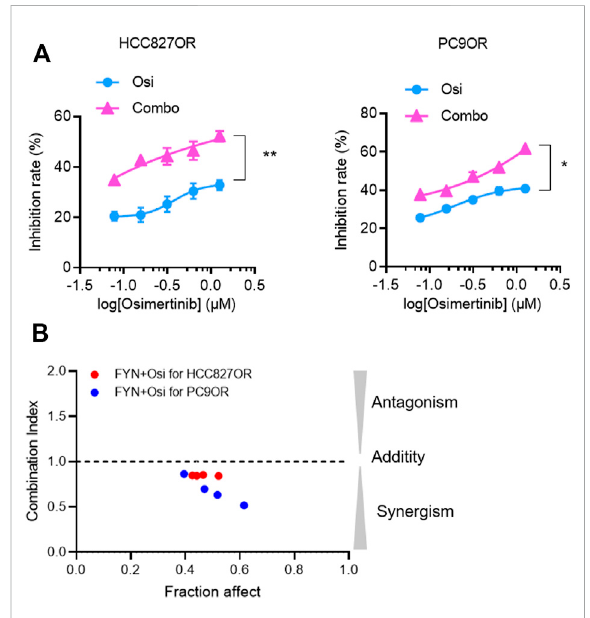
FIGURE 2 Synergistic effects of FYN with osimertinib on osimertinib- resistant NSCLC cells lines. (A) HCC827OR cells were treated for 48 h with 4 μ M osimertinib alone, or in combination with 250 μ g/ ml FYN. PC9OR cells were treated for 48 h with 6 μ M osimertinib alone, or in combination with 500 μ g/ml FYN. (B) Synergistic effects of 250 μ g/ml FYN on HCC827OR cells (red circles), or 500 μ g/ml FYN on PC9OR cells (blue circles), combinedwithvariousdoseofosimertinib.CI(combinationindex) value was calculated as described in Materials and Methods. Osi, osimertinib; FYN, Feiyanning Formula; Combo, combination of Feiyanning Formula and osimertinib. * p < 0.05, ** p <